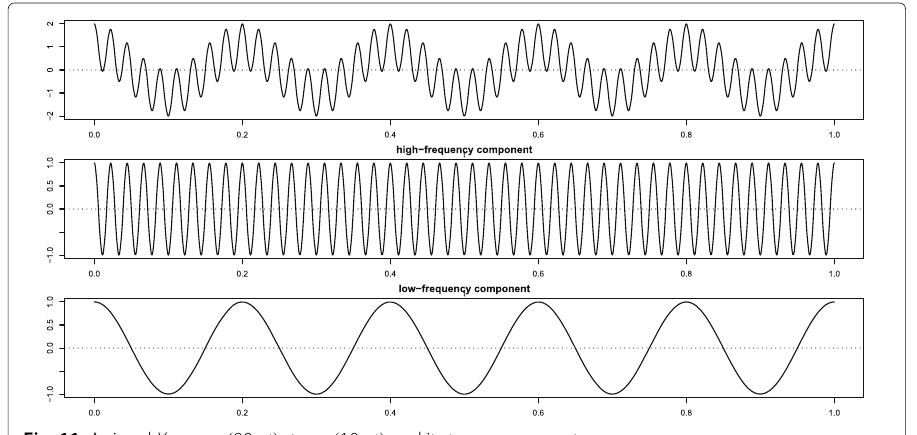
Fig. 11 A signal X t = cos ( 90 π t ) + cos ( 10 π t ) and its two components